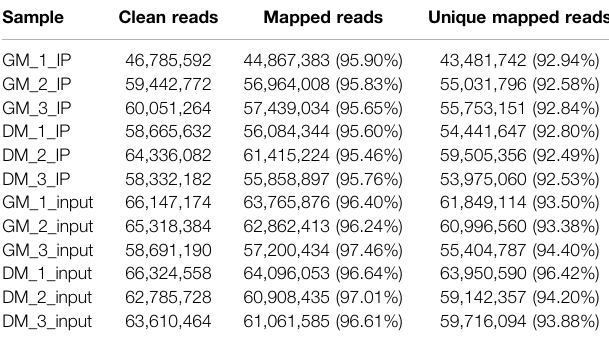
TABLE 1 | Summary of sequencing data and read-alignment statistics from m 6 A-seq in bovine skeletal myoblasts and myotubes. Sample Clean reads